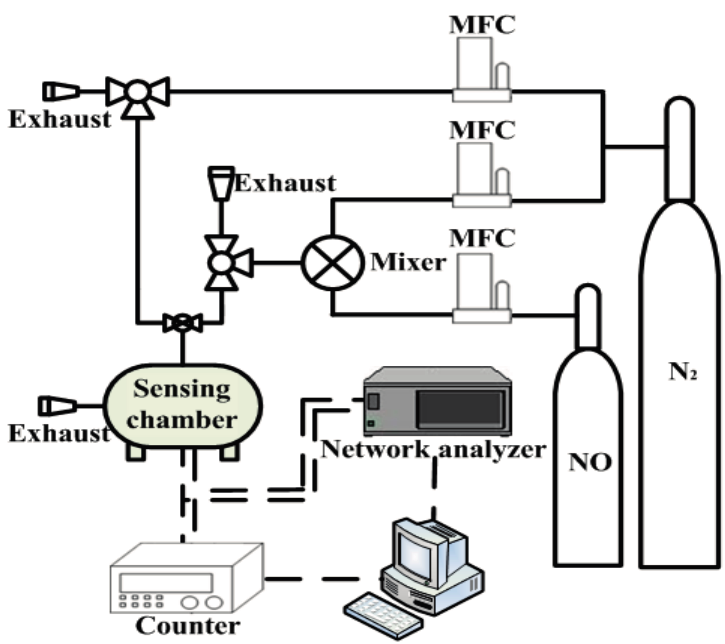
Figure 2. Experimental setup for measuring NO